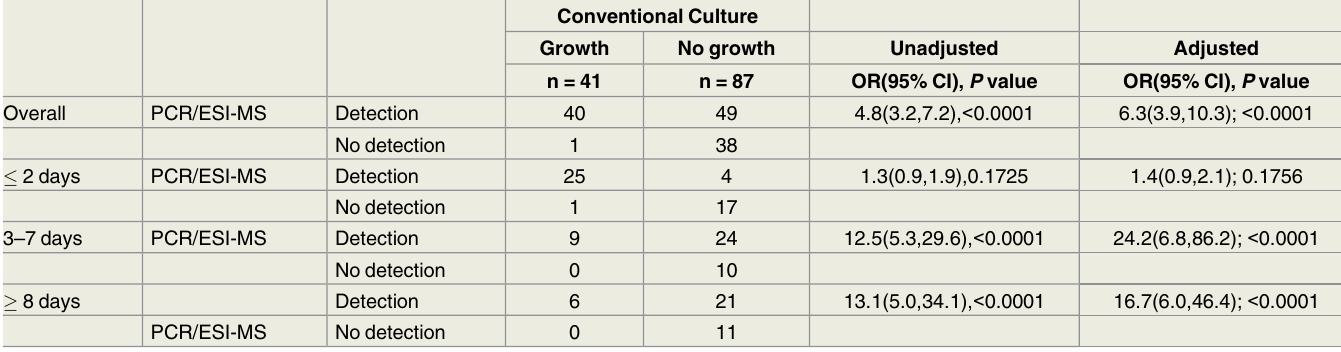
Table 2. Adjusted and unadjusted odds ratio of pathogen detection by